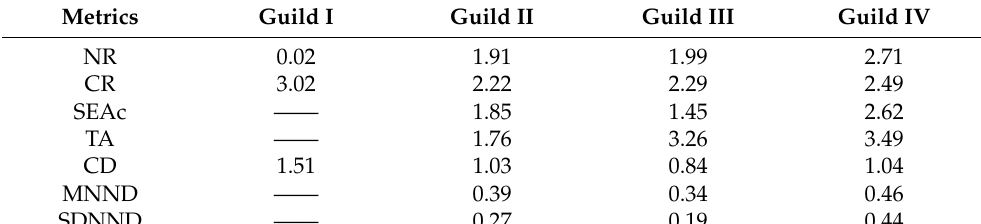
Figure 3. Hierarchical cluster analysis (Bray–Curtis similarity) and non ‐ metric multidimensional scaling (NMDS) ordination based on δ 13 C and δ 15 N signatures for trophic guilds of fish in the mid ‐ stream of the Chishui River. Guild I represents herbivores; Guild II represents herbivore ‐ based omnivores; Guild III represents carnivore ‐ based omnivores; Guild IV represents carnivores. Table 2. Analysis of similarity (ANOSIM) to each pair of trophic guilds of fish in the midstream of the Chishui River. Table 3. Trophic niche metrics for trophic guilds of fish in the midstream of the Chishi River.